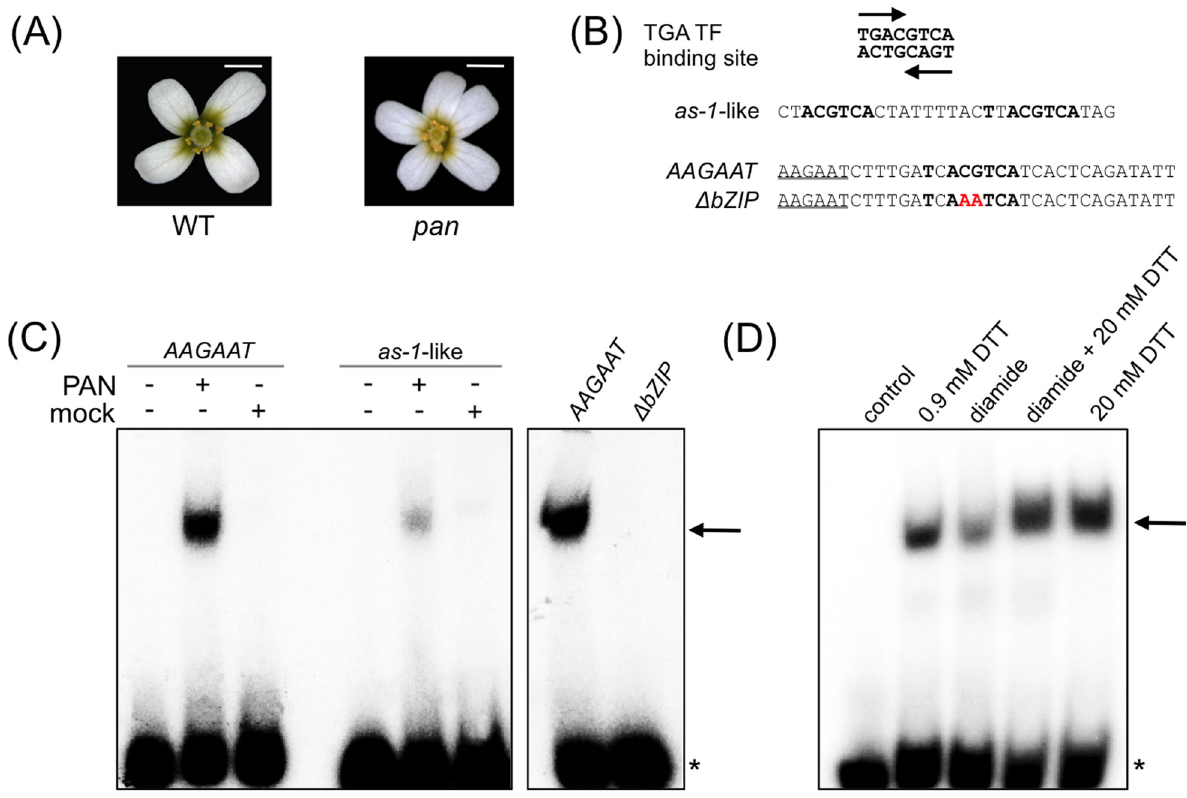
Fig 1. Analysis of redox-dependent PAN DNA-binding. (A) Arabidopsis wild-type flowers are composed of four sepals, four petals, six stamens and two fused carpels. Flowers of pan mutants form three pentameric whorls with five sepals, five petals, five stamens and two normal carpels. Scale bar 1 mm. (B) Sequence of the palindromic core TGA DNA-binding motif is shown on the top and the three used binding sites comprising the core motif below. The as-1 -like motif from the Arabidopsis PR1 promoter comprises two TGA binding sites. The AAGAAT motif from the second intron of AG encompasses one central TGA binding site with one nucleotide exchange, the name- giving 5 ’ AAGAAT motif is underlined. Mutagenesis of two nucleotides (indicated in red) abolishes binding to the Δ bZIP motif. (C) EMSA analysis of the PAN interaction with the AAGAAT , as-1 -like and Δ bZIP motifs. Radioactive-labeled DNA probes were incubated with PAN protein or with a mock translation under reducing conditions (0.9 mM DTT). The arrow indicates DNA-protein complex formation and the asterisk marks free DNA probe. D) Analysis of redox-dependent binding of PAN to the AAGAAT motif. For comparison of reducing and oxidizing conditions, PAN protein was incubated prior to DNA-binding with 0.9 mM or 20 mM DTT and with 2 mM diamide, respectively. Reversibility of the redox-dependent DNA-binding was analyzed by the addition of 20 mM DTT after a 2 mM diamide treatment. The control reaction was conducted without protein addition.